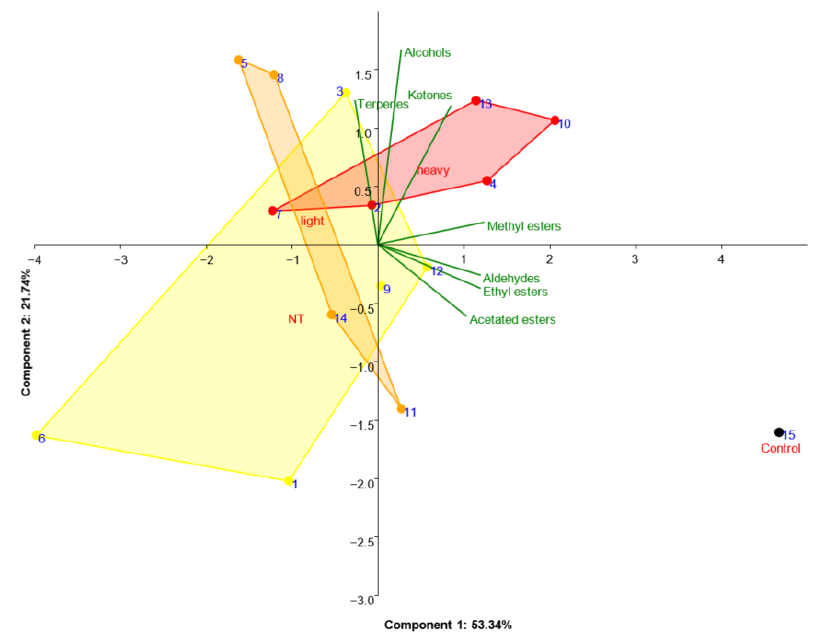
Figure 1. PCA biplot representing spirits aged with different alternative products. The graph highlights the effect of toasting on the spirit composition on volatile compounds grouped by chemical structure. Yellow, NT, non-toasted wood; red, heavy toasting; orange, light toasting.